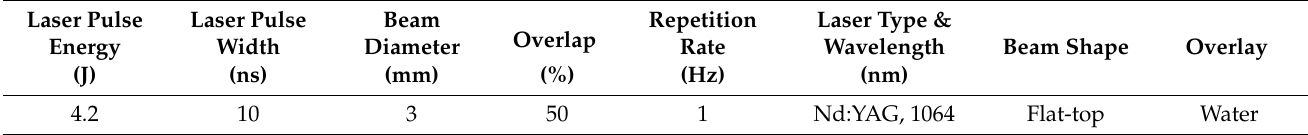
Table 1. LSP process